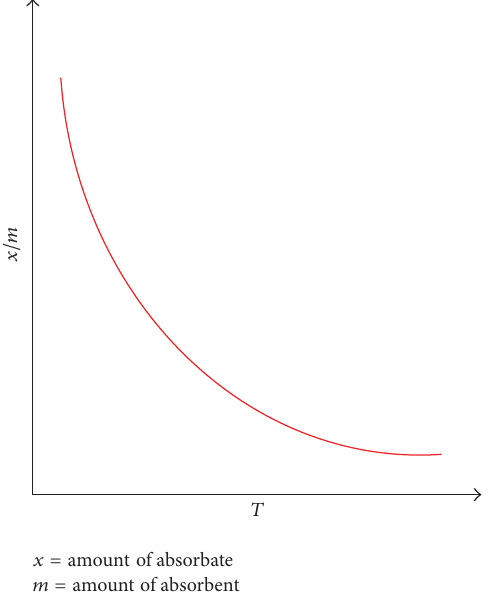
Figure 2: Physical adsorption versus temperature.